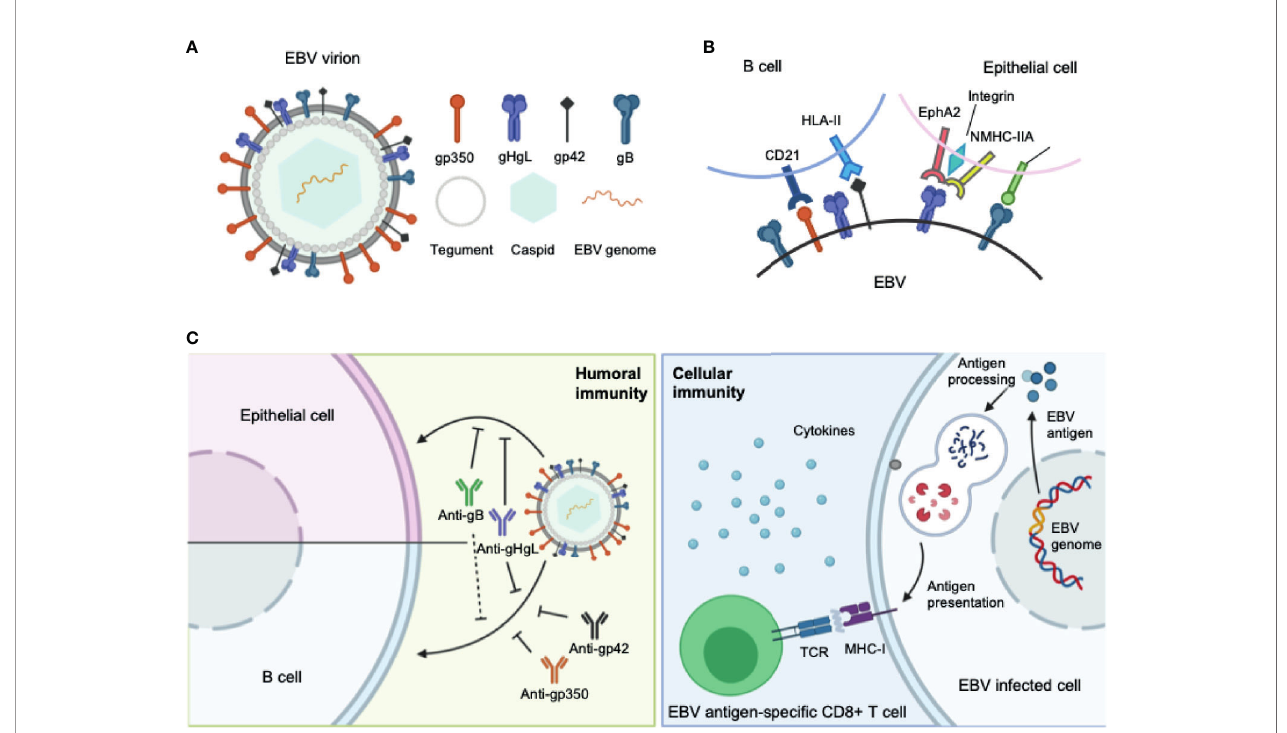
FIGURE 1 | (A) Structure of the EBV virion. As an enveloped double-stranded DNA virus, the virion of EBV consists of a lipid membrane, tegument, viral capsid and the packed EBV genome. Glycoproteins are distributed on the virion membrane and are crucial for recognition, host cell attachment and membrane fusion. (B) The major interaction pattern of host cell receptors and the EBV membrane glycoproteins. EBV infects B lymphocytes and epithelial cells via different combinations of ligand – receptor interaction. (C) Humoral and cellular immunity against EBV infection. In humoral immunity, antibodies against various glycoproteins play different roles in the neutralization process. After infection, EBV antigen can be presented, inducing a cytotoxic CD8 + T cell response against infected